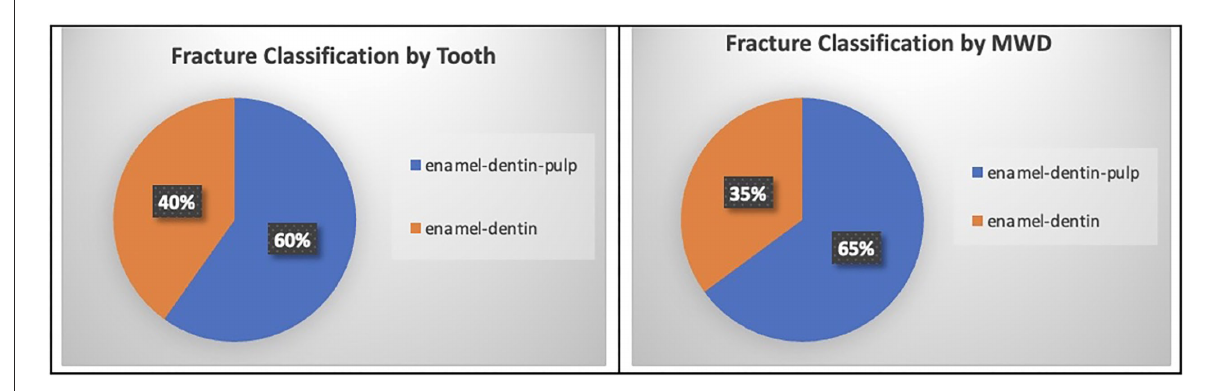
FIGURE2 Graphical projection of the association between age in months and the percentage of TDI. Note that the enamel-dentin fractures were highest in the 24–48-month MWDs and the enamel-dentin-pulp fractures were highest in the 72 month and older MWDs. There was statistical significance between enamel-dentin-pulp fractures and age ( P ≤ 0.0001).